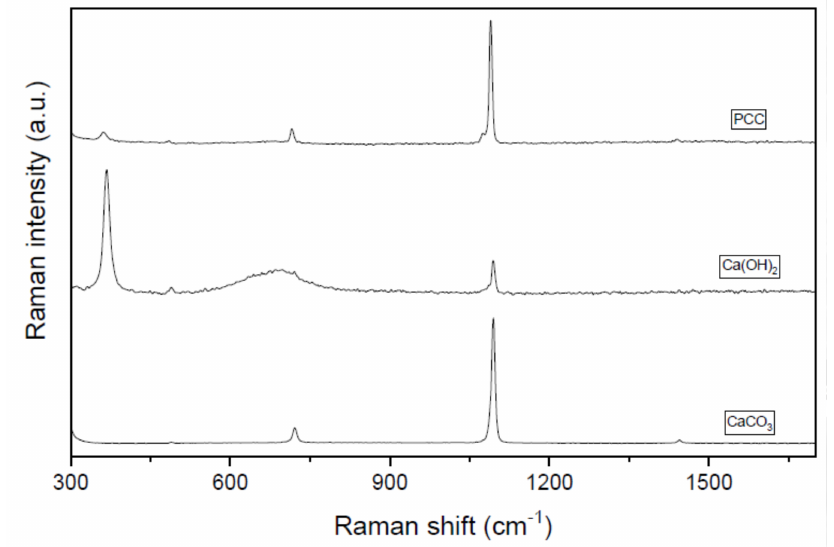
Figure 6. Raman spectra of the PCC obtained (time = 30 min, T = 50 ◦ C, R = 1.2) and the Ca(OH) 2 and CaCO 3